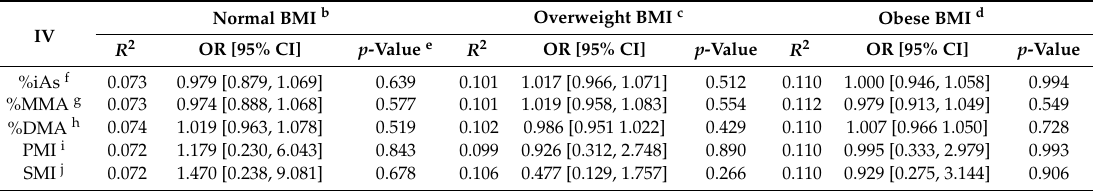
Table 5. Binary logistic regression; DV: Metabolic syndrome in men, fully adjusted model a